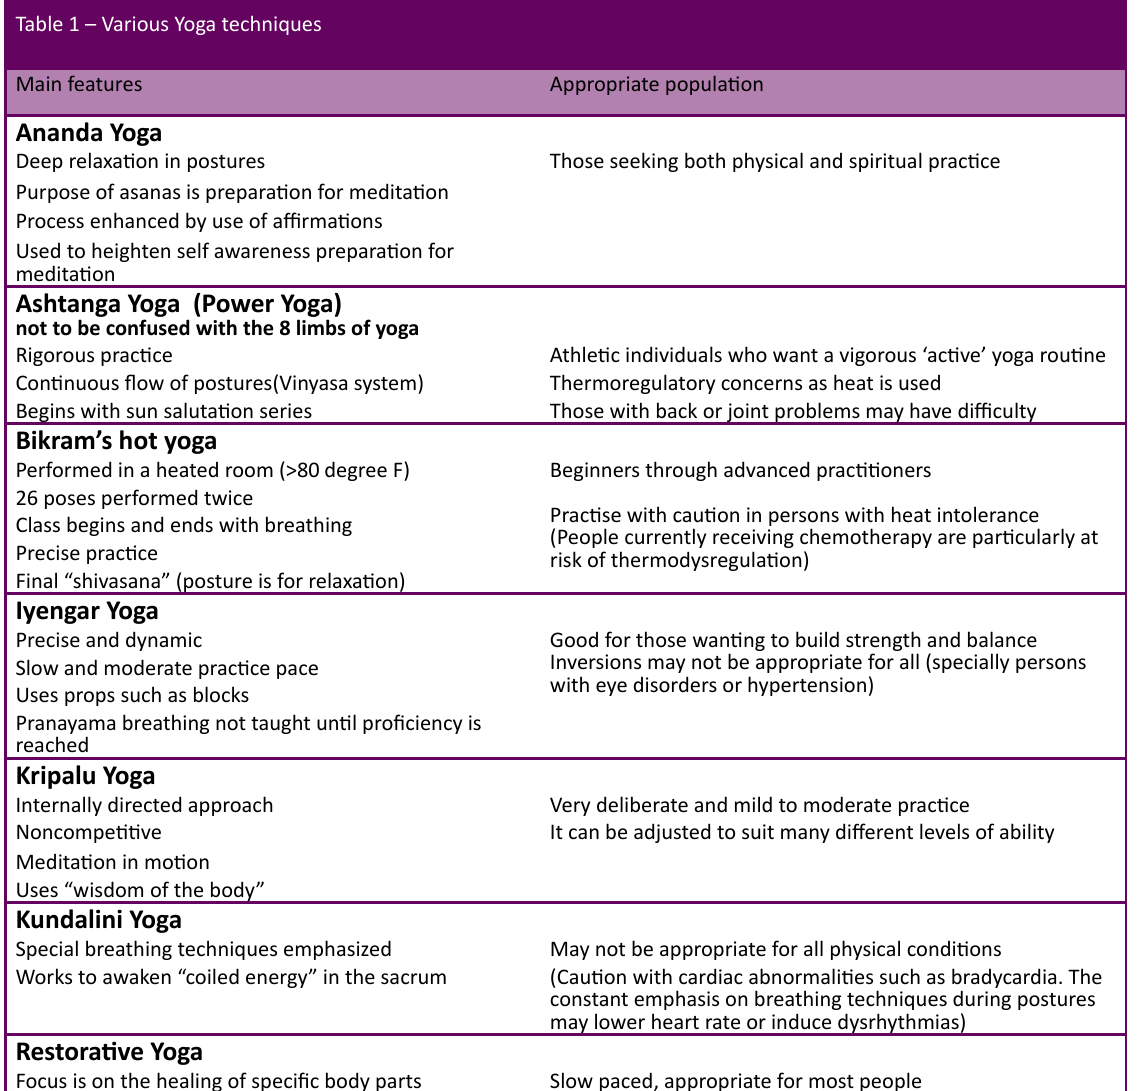
Table 1 – Various Yoga techniques Main